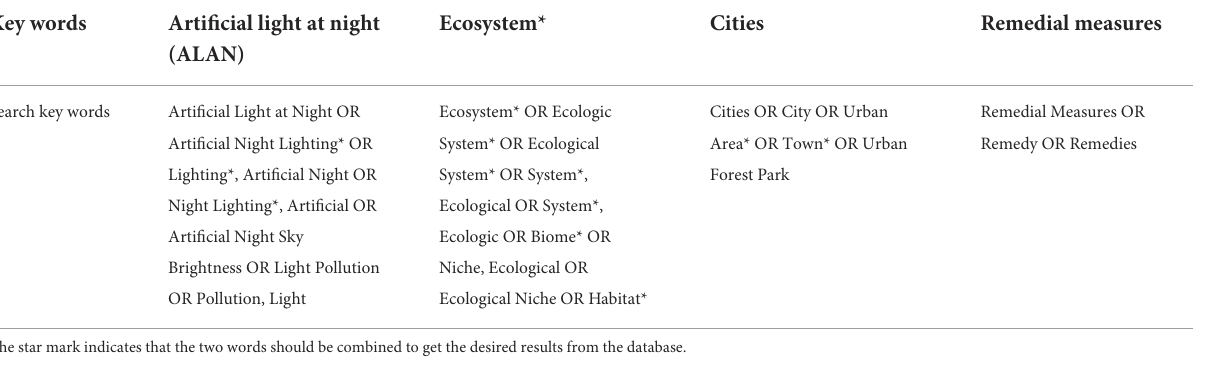
FIGURE2 Flowchart of the literature search and selection process.